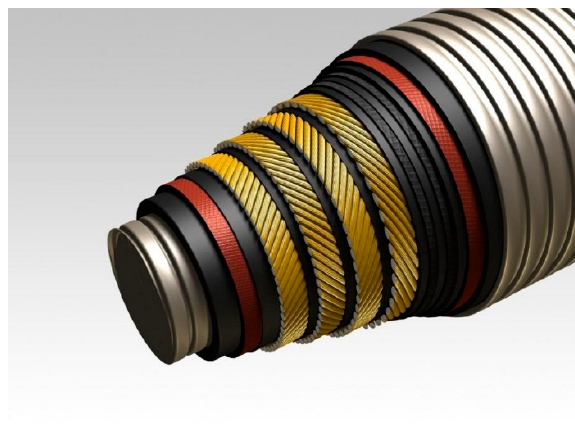
Figure 1. Typical structure of a high-pressure oil hose [1].